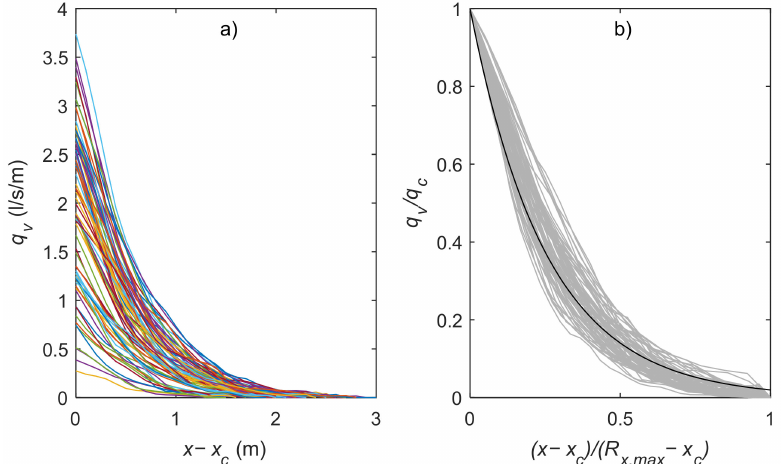
Figure 9. ( a ) Cross-shore distribution of overtopping discharge q v relative to the revetment crest location during 1DR where the data from each 20 min segment is represented using a different colour. Note that 20 min segments where the entire structure was overtopped such that overtopping events reached the sand beach landward of the revetment ( x = 264.1 m) were excluded from this analysis. ( b ) Overtopping discharge normalised by the overtopping discharge at the crest as a function of distance from the revetment crest normalised by the measured incursion distance for each segment. The grey lines indicate the data for each segment and the solid black line shows the best fit power law and exponential decay functions respectively.